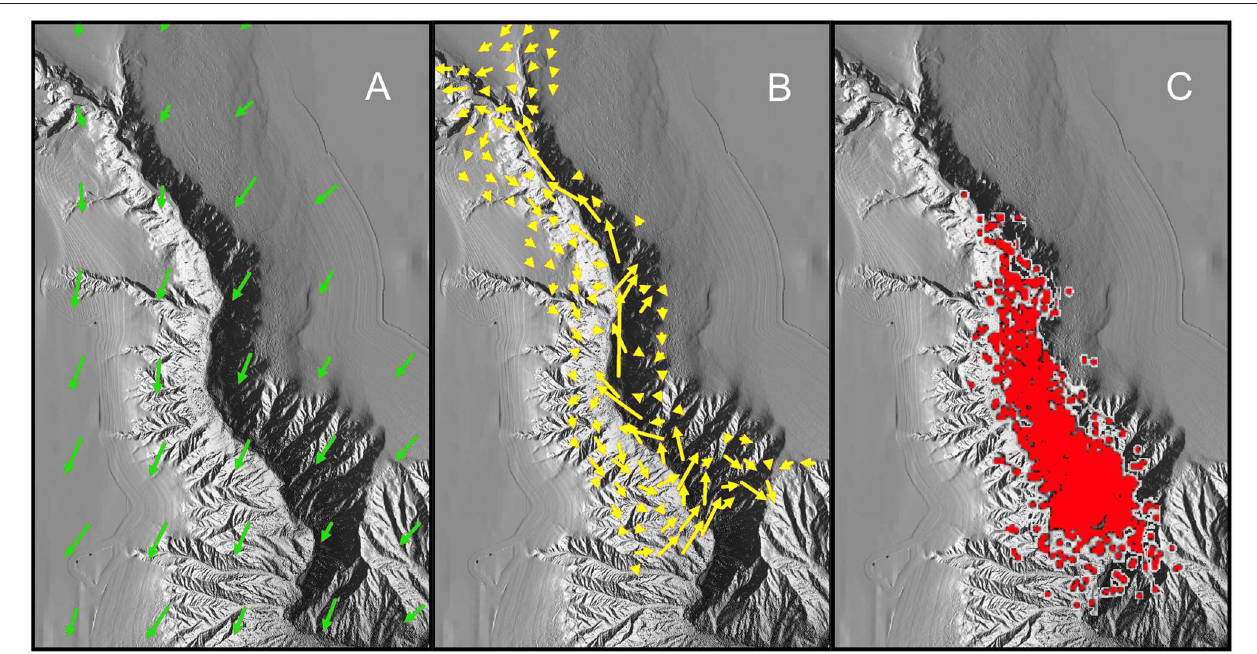
FIGURE 7 | Illustration of hypothesis explaining the observed distribution of the fish assemblage: (A) Modelled surface current over The Gully in August—length of arrows proportional to volume of flow (simplified from Shan et al., 2014b); (B) Modelled volume transport of water below 200m depth in August (simplified from Shan et al., 2014b); (C) Locations of surface observations of northern bottlenose whales (mapped by Hooker et al., 2002b), here supposed indicative of the distribution of concentrations of Gonatus spp. at depth. The modelled current and volume transports differ in detail from the empirical observations summarized in section Oceanography of The